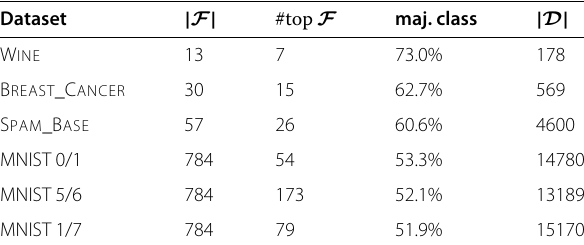
Table 1 Dataset description